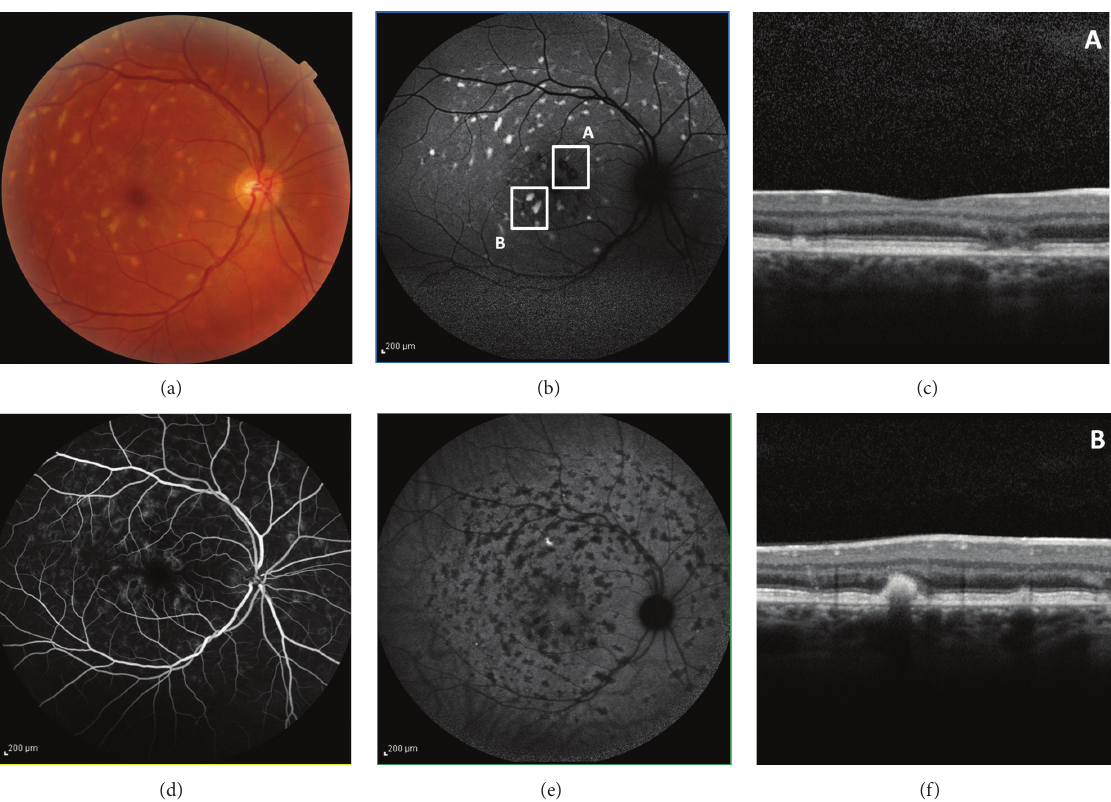
Figure 2: Color photograph shows macular atrophy and retinal flecks in a Stargardt patient. OCT scans are illustrated by the arrows 1 and 2. The autofluorescent frame clearly delineates the retinal flecks. Thin and open arrows point to two of the flecks, respectively, crossed by scans 1 and 2. Fluorescein angiography shows the dark choroid appearance, and the hypofluorescent flecks are hardly discernable in the hyperfluorescent background because of RPE changes. On ICG, late phase (30min), the hypofluorescent lesions appear more numerous than the autofluorescent flecks, and there is sparing of the peripapillary area. The SD-OCT scan in square A shows a small hyperreflective lesion located at the inner part of the RPE layer, called type 1 deposit, and macular atrophy. The SD-OCT scan in square B shows a small hyperreflective linear lesion located at the level of the outer nuclear layer and clearly distinguished from the RPE layer, called type 2